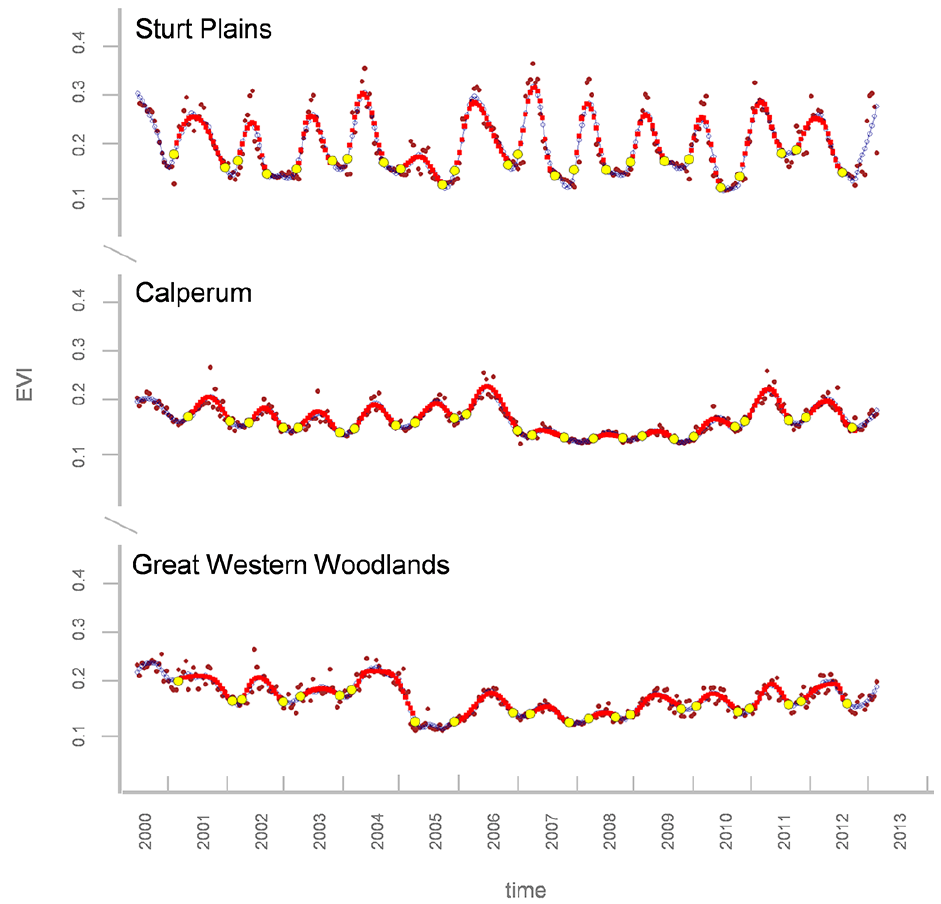
Figure 3. Examples of temporal variability of the characterized phenological cycles for the Sturt Plains, Calperum, and Great Western Woodlands sites (refer to Fig. 1 and Table 1 for the sites’ locations and descriptions, respectively), based on 14 years of MODIS EVI data after screening out low-quality observations (brown circles), EVI time series after gap filling and smoothing (blue circles), fitting seven-parameter double logistic functions (red squares) and identifying the start- and end-of-cycle points (yellow circles) delineating the characterized phenological